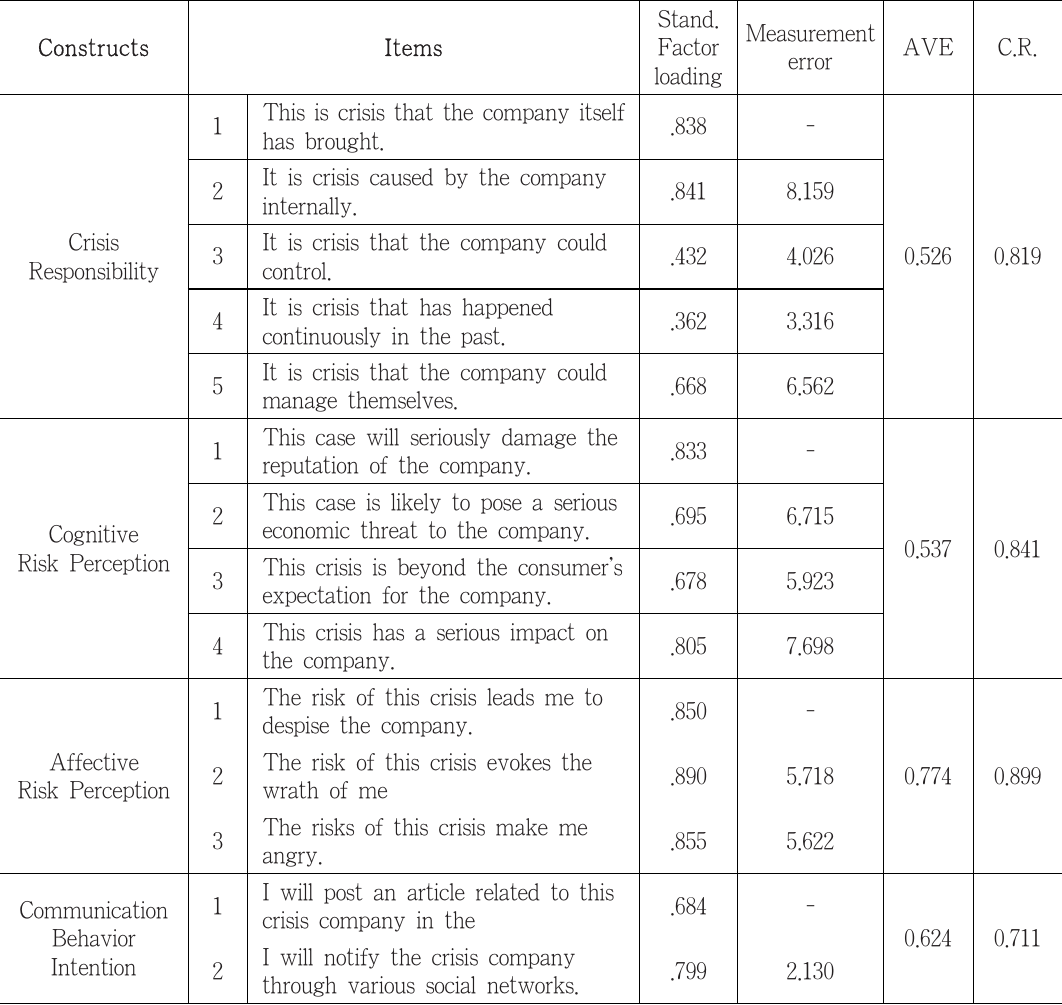
<Table 1> the results of confirmatory factor analysis for